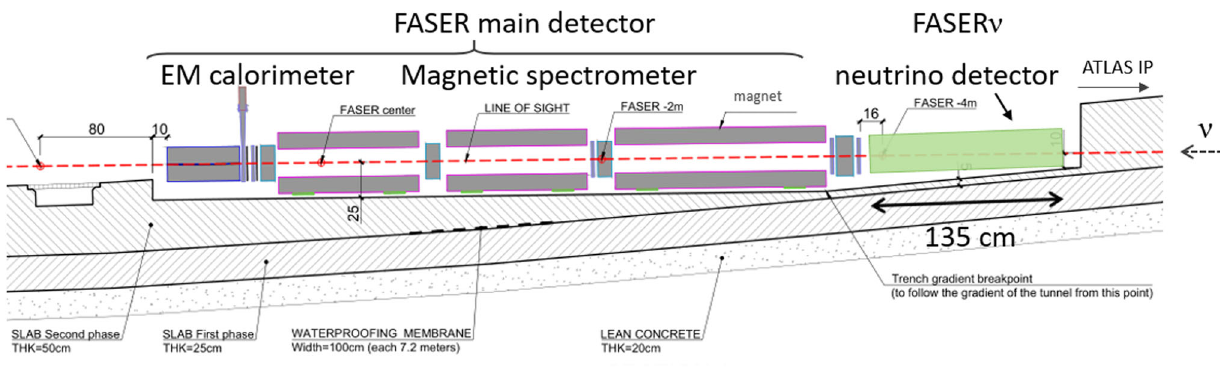
Fig. 6 Side view of the FASER main detector and FASER ν in side tunnel TI12 Fig. 7 Schematic of the detector structure and the topology of various neutrino signal events that can be seen in the